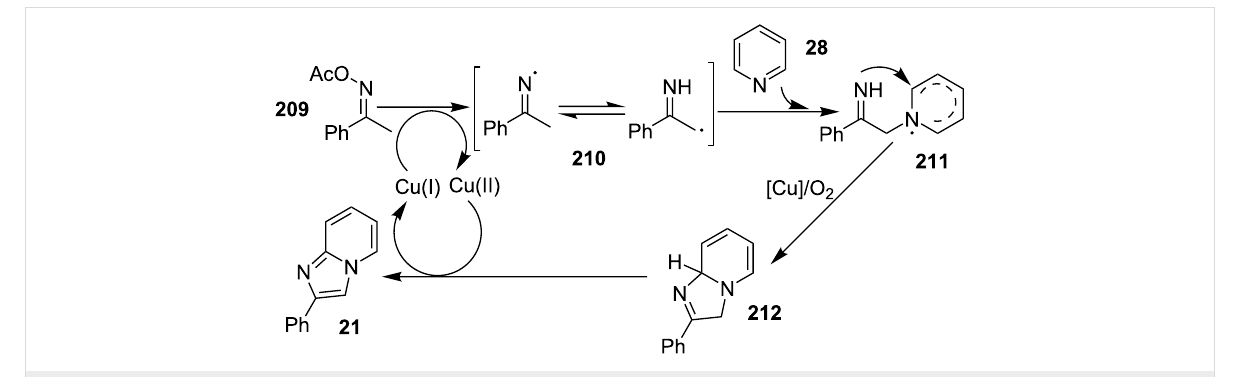
Scheme 74: CuI-catalyzed pathway for the formation of imidazo[1,2- a ]pyridine.